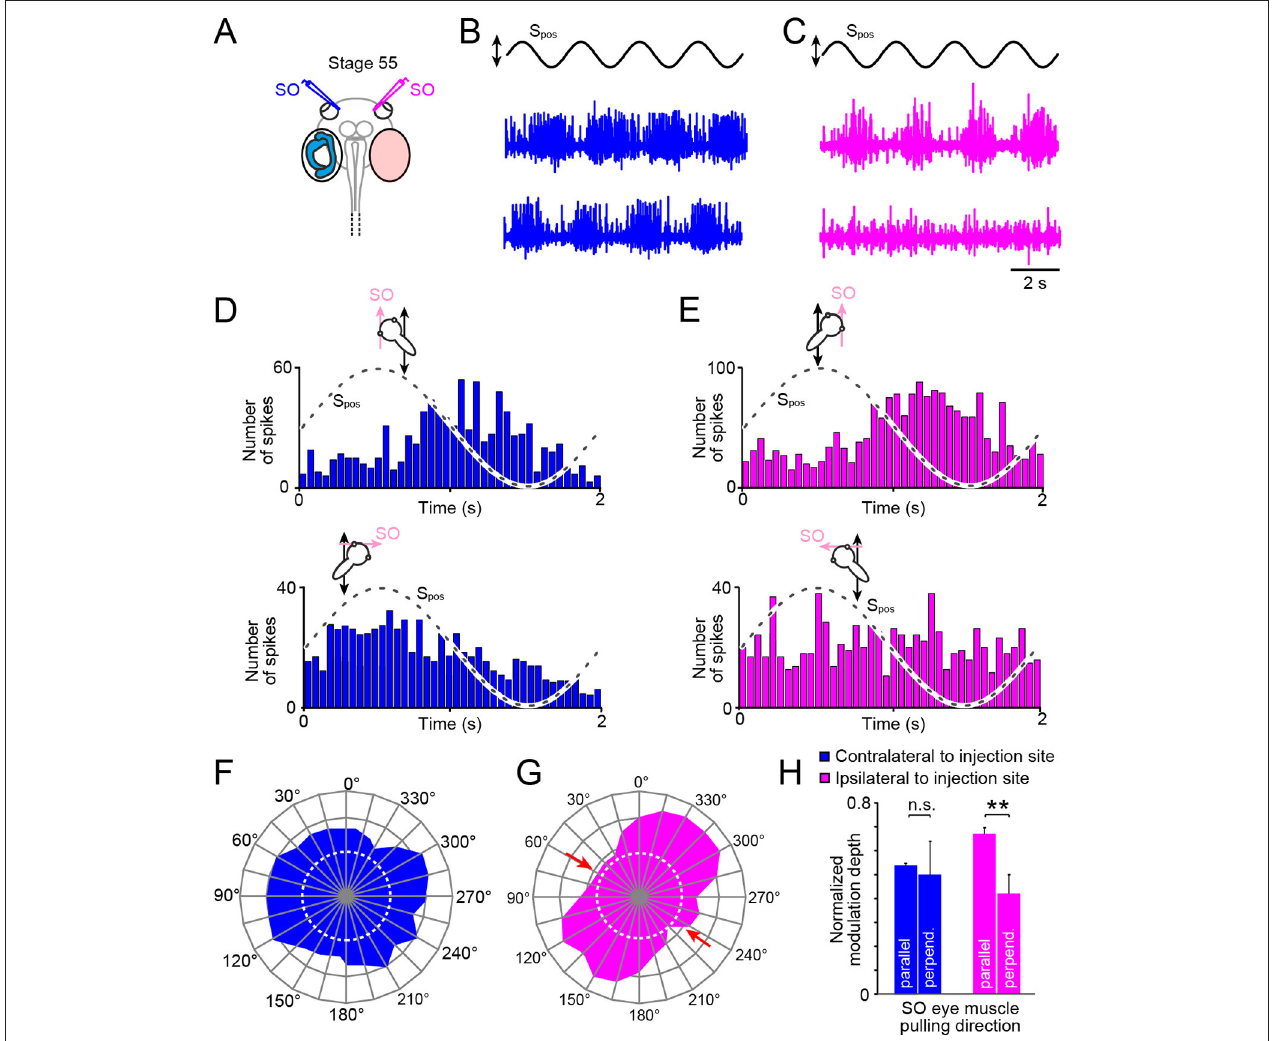
FIGURE 5 | Impact of unilateral semicircular canal-deficiency on the developmental tuning of translational motion-evoked SO nerve responses. (A) Schematics depicting the presence of semicircular canals in the left and the absence thereof in the right inner ear in a stage 55 tadpole. (B,C) Spike discharge of the left (B) and right SO nerve (C) during four cycles of sinusoidal horizontal linear translation on a sled at 0.5Hz and 0.49 m/s 2 peak acceleration (S pos ; black trace) in a direction parallel (upper blue and magenta trace) and perpendicular to the SO eye muscle pulling direction (lower blue and magenta trace), respectively. (D,E) PSTH (bin width: 50ms) of averaged firing rate modulation over a single cycle (dashed sine waves in D,E ) of sled motion (from n = 20–30 cycles) of the left (D) and right SO nerve (E) during the two orthogonal translation directions. (F–H) polar plot of SO nerve discharge modulation magnitudes (F,G) and bar plot (H) of normalized firing rate modulation during translation along the two orthogonal directions of the left (blue) and right SO nerve (magenta); note the absence of directionally tuned responses of the SO nerve contralateral to the semicircular canal-deficient inner ear, indicated by the omni-directional vector plot (blue in F ) and similar response magnitudes (blue bars in H) during translation parallel and perpendicular to the SO eye muscle pulling direction ( n = 8), at variance with the corresponding responses of the SO nerve ipsilateral to the impaired inner ear (magenta vector plot in (G) and bar plot in (H) ; ** p ≤ 0.01; Wilcoxon signed-rank test); red arrows in (G) indicate response components at spatial orientations, which became abolished during development. Dotted white circles in (F) and (G) indicate the SO nerve resting rates. n.s., not significant; SO, superior oblique; S pos , stimulus position of the sled.